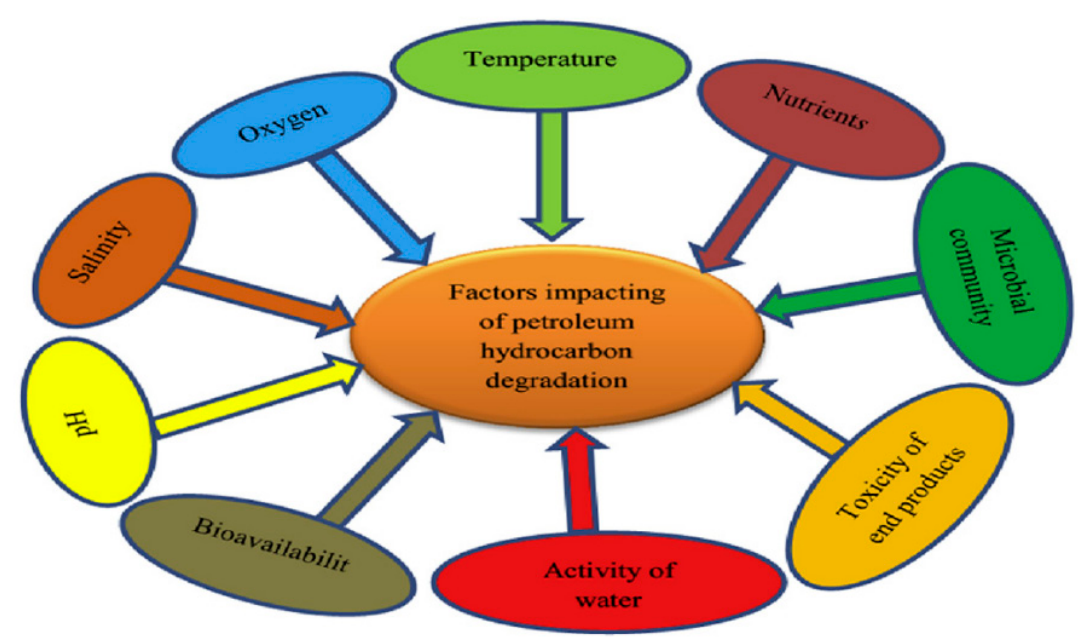
Figure 6. Schematic representation of factors that influence microbial remediation.